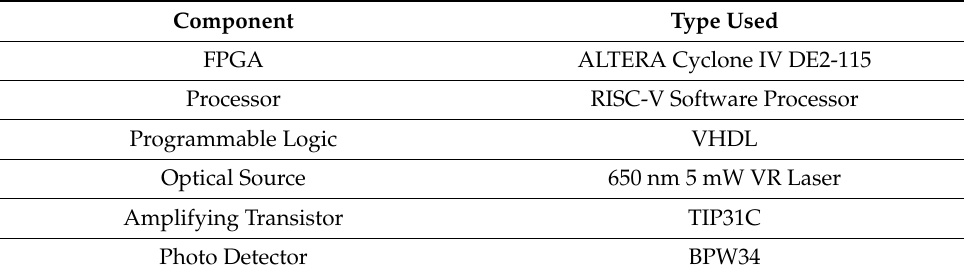
Table 4. Components Properties.